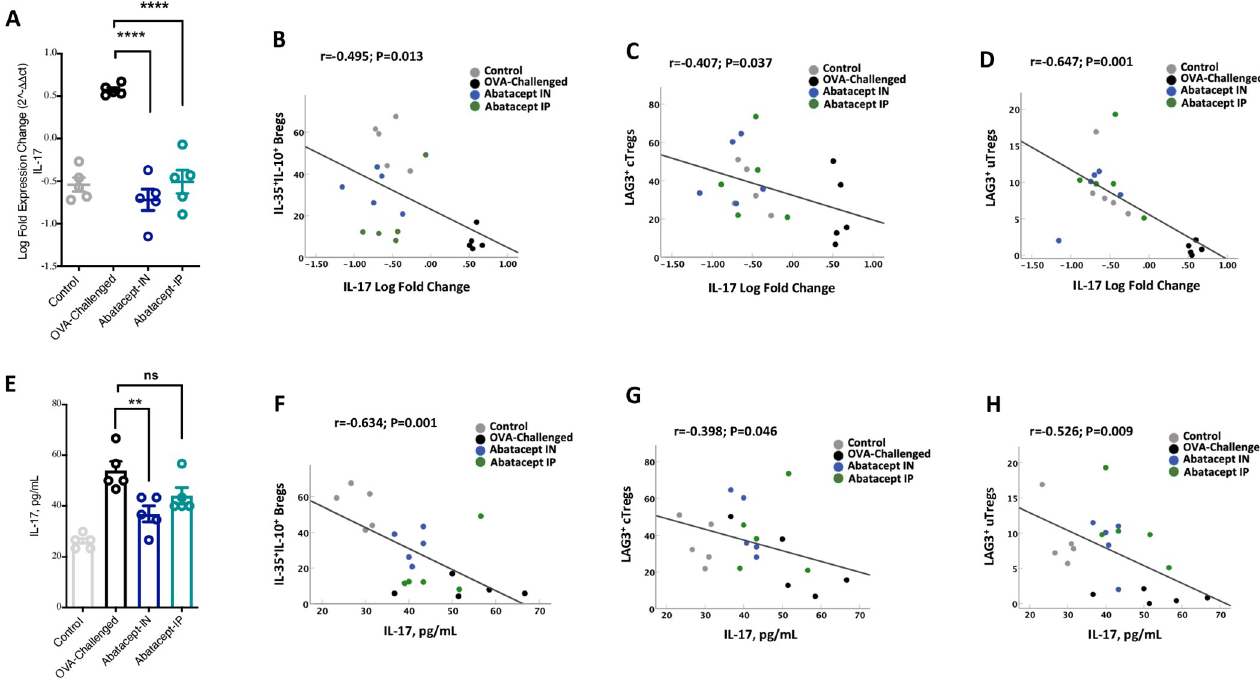
Fig 6. Lung tissue and serum levels of IL-17 are suppressed following abatacept treatment and negatively correlated with blood Breg and Treg levels. (A) Lung tissue gene expression level of IL-17 following treatment with the abatacept IN and IP. (B-D) Correlation between percentage of IL-135 + IL-10 + producing Bregs, LAG3 + cTregs, or LAG3 + uTregs in the lung and lung level of IL-17. (E) Serum level of IL-17 following treatment with the abatacept IN or IP. (F-H) Correlation between percentage of IL-135 + IL-10 + producing Bregs, LAG3 + cTregs, or LAG3 + uTregs in the lung and serum level of IL-17. Lung tissues of 5 mice and PBMCs of 10 mice were used. Statistical test; Pearson’s correlation coefficient with a one-sided test for significance (P < 0.05 significant).